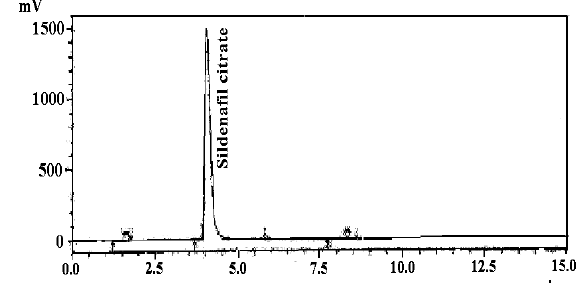
Figure 2 . Chromatogram of sildenafil citrate